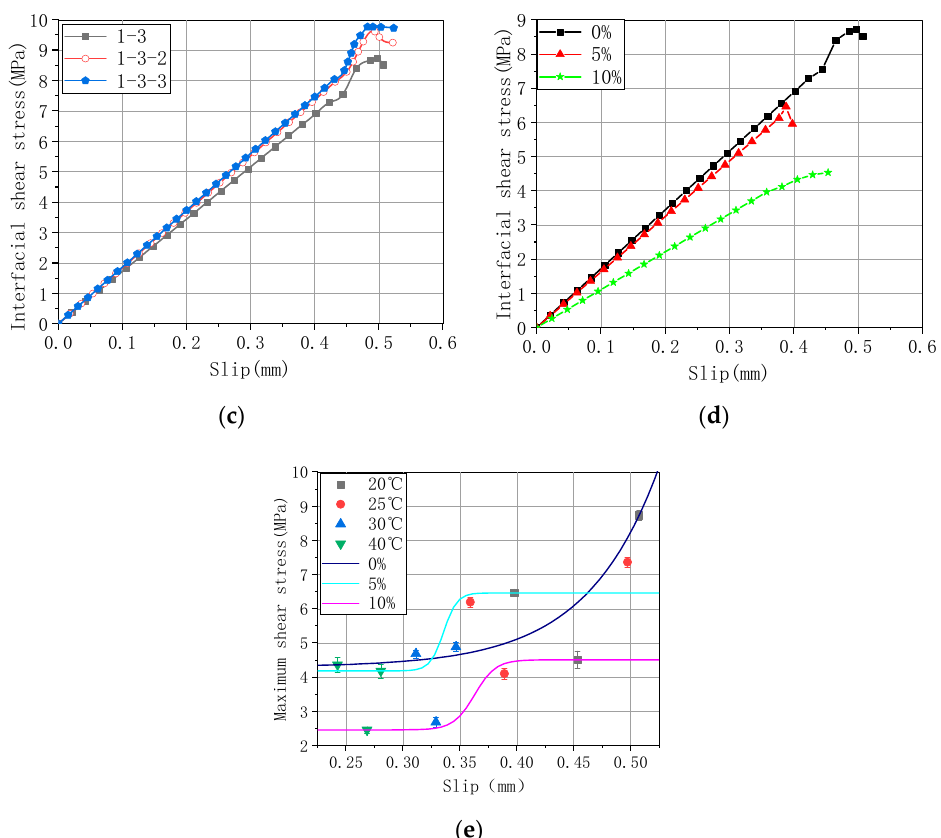
Figure 15. Interfacial shear stress and slip of CFRP bonding concrete arch. ( a ) Shear stress and slip curves for different CFRP lengths, ( b ) shear stress and slip curves for different, T.; ( c ) shear stress and slip curves for different CFRP layers, ( d ) shear stress and slip curves for different H, ( e ) maximum interfacial shear stress and slip curves for hygrothermal coupling.